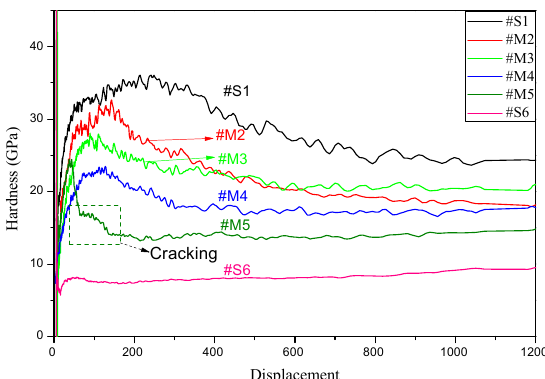
Figure 6. Hardness of coatings with the tip displacement at (0~1200 nm), #S1 (Ti-0 nm), #M2 (Ti-25 nm), #M3 (Ti-50 nm), #M4 (Ti-100 nm), #M5 (Ti-150 nm), #S6 (Ti monolayer coating).